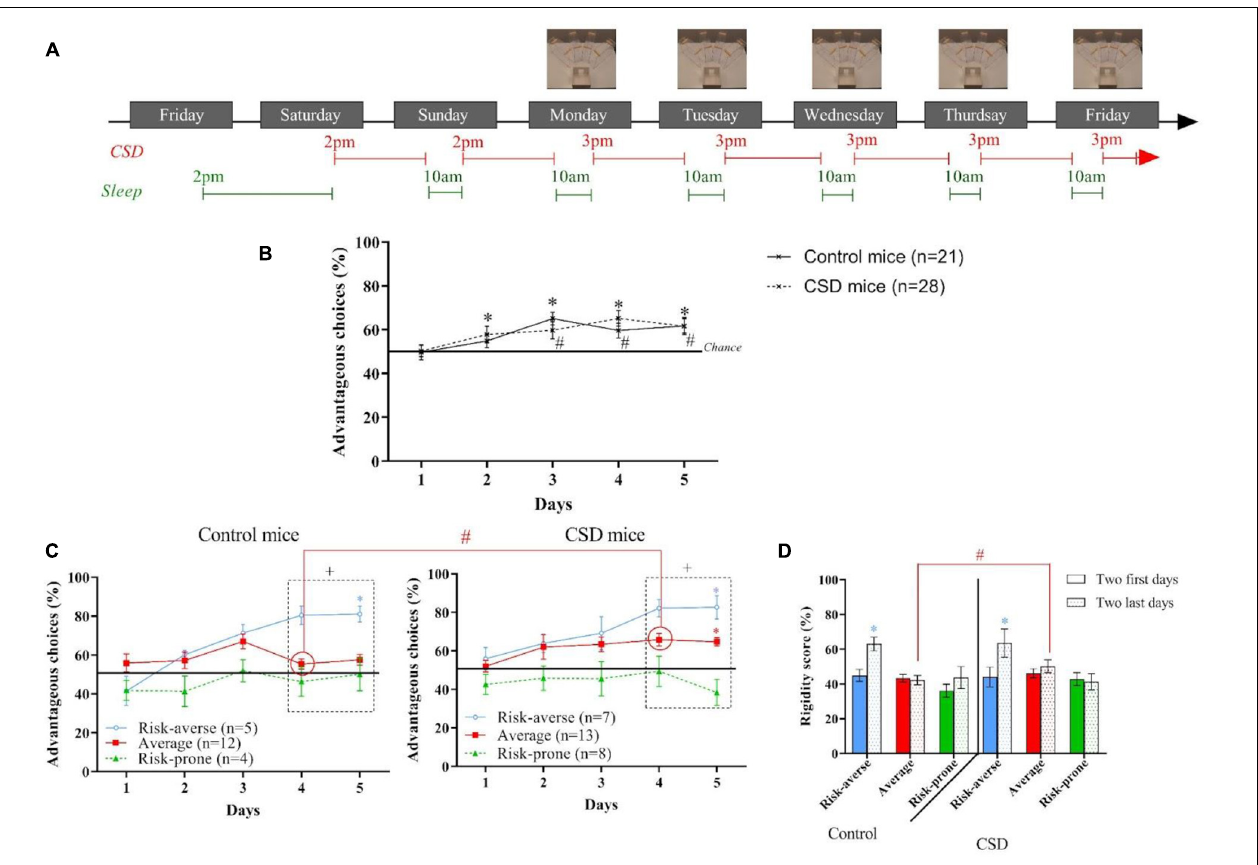
FIGURE 4 | (A) Protocol of the Chronic Sleep Debt (CSD) during the Mouse Gambling Task (MGT). (B) Evolution of the preferences of animals as a group during the MGT for control mice and CSD mice. ∗ and # p < 0.05 from chance level. (C) Evolution of preferences of risk-averse, average and risk-prone mice from days 1 through 5 in the MGT for control and CSD mice. ∗ p < 0.05 from chance level. + , p < 0.05 differences from the three groups. #, p < 0.05 differences between the three groups (Kruskal Wallis). (D) Rigidity score of risk-averse, average and risk-prone mice at the beginning and the end of the MGT for control and CSD mice. ∗ p < 0.05 difference between the first two and last two days. # p < 0.05 differences between control and CSD mice. Adapted from Pittaras et al.,